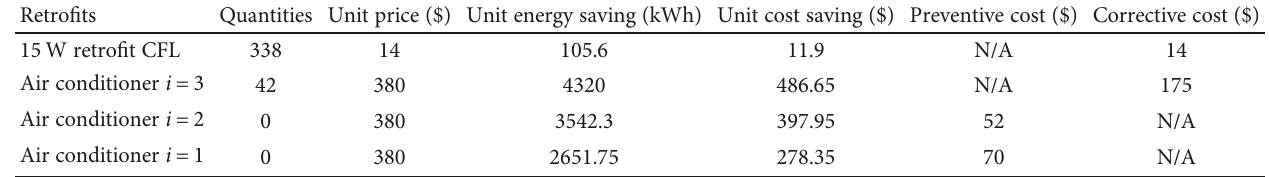
Table 2: Characteristics of retro fi tted items.